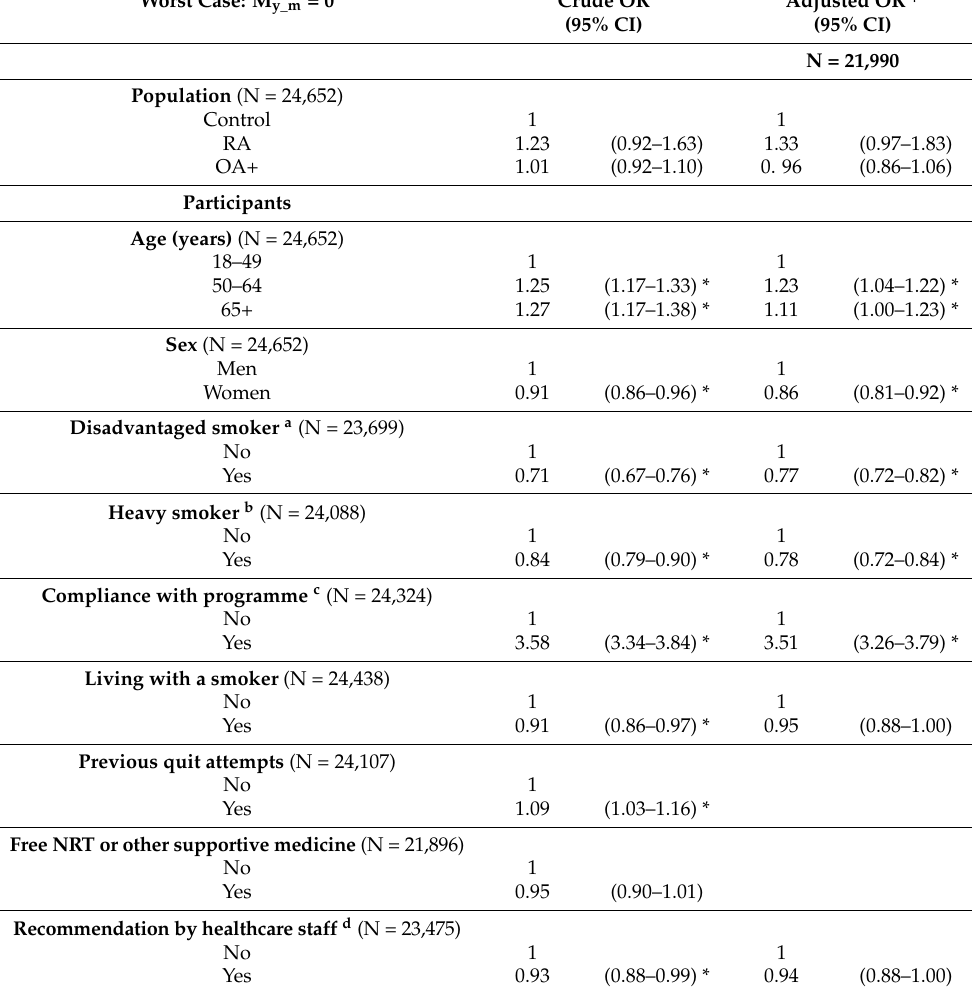
Table A1. Odds ratio (OR) for predictors of continuous abstinence at six months, based on a worst- case analysis, where all patients lost to follow up were assumed to be